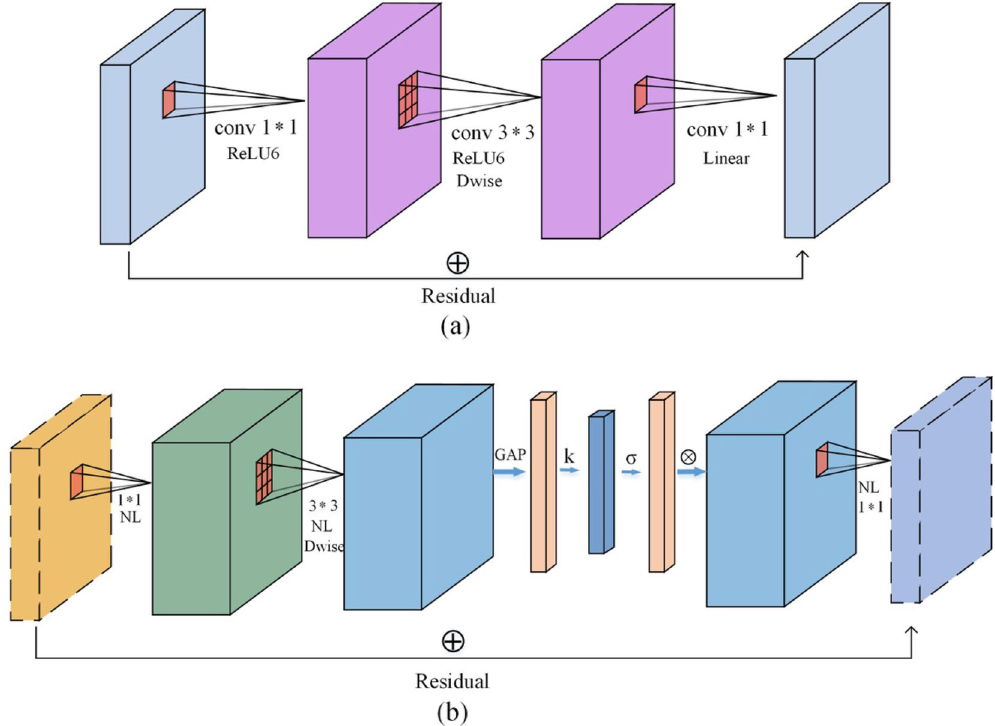
Figure 7. ( a ) Inverted residuals block; ( b ) TF-Bottleneck